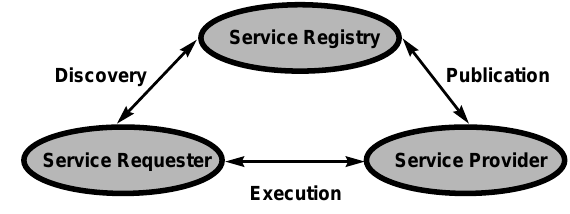
Figure 1. Traditional SOA Architecture